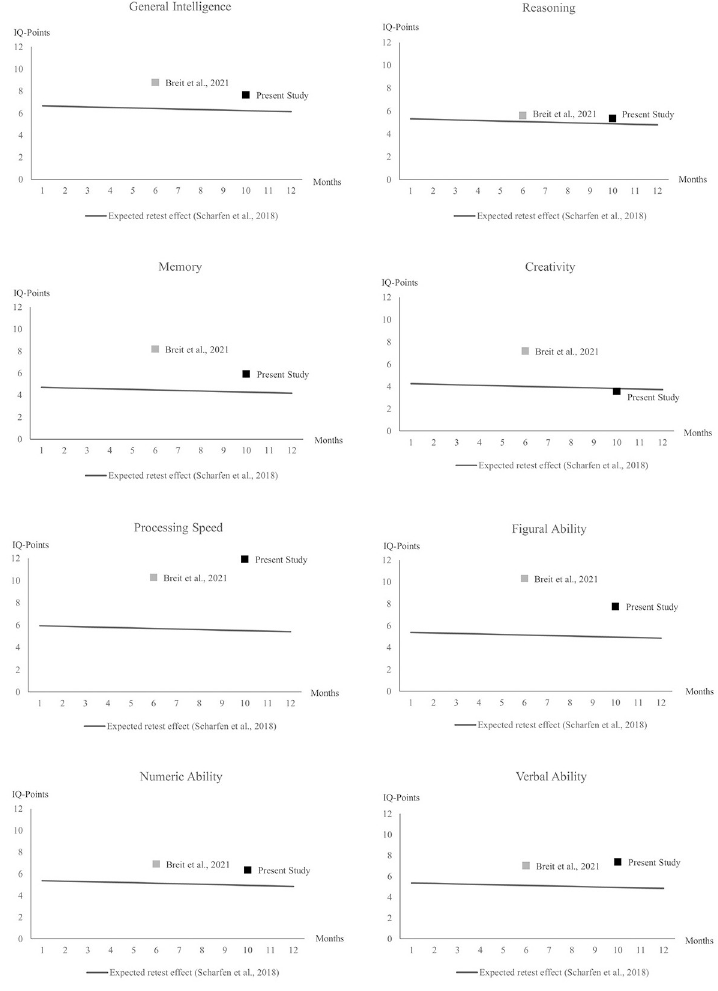
Fig 9. Observed mean-level change in the present study (2020 sample) and the BIS-HB standardization subsample reported in Breit et al., 2021